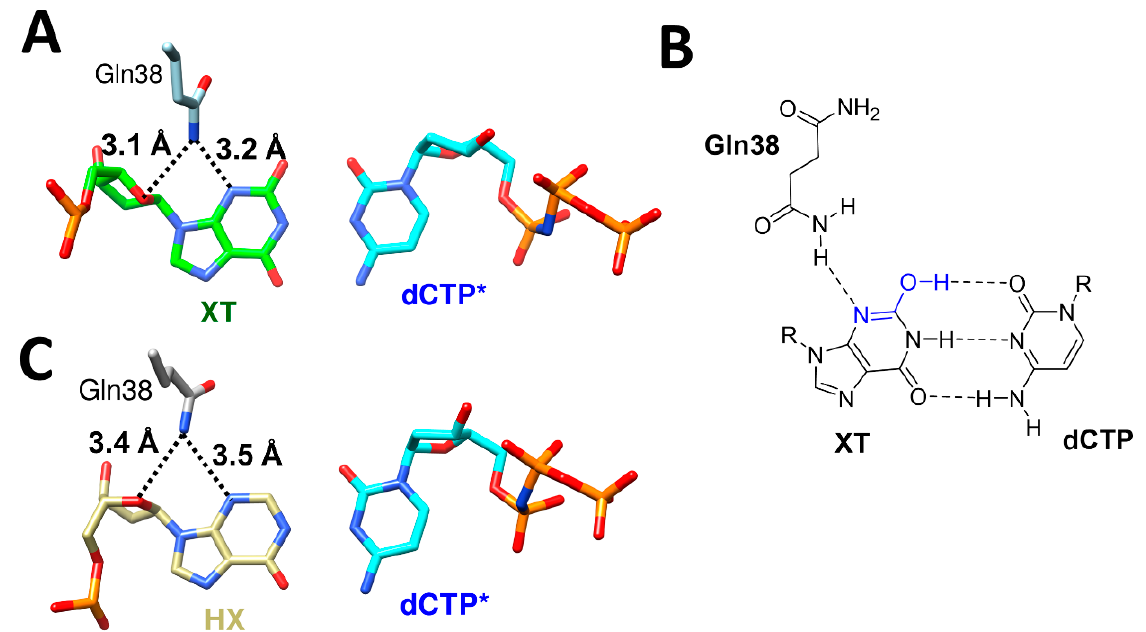
Figure 7. The bypass of XT (PDB ID: 6WK6) and HX (PDB ID: 6MQ8) by pol η and the role of Gln38 in the bypass. ( A ) The canonical Watson–Crick base pair between XT and the incoming dCTP* and the extra stabilization from Gln38. ( B ) The Watson–Crick base pair between XT and dCTP* utilized the enol tautomer of XT, and this enol tautomer was stabilized by the hydrogen bonding with Gln38. ( C ) The canonical Watson–Crick base pair between HX and the incoming dCTP, and Gln38 is in close proximity with HX.